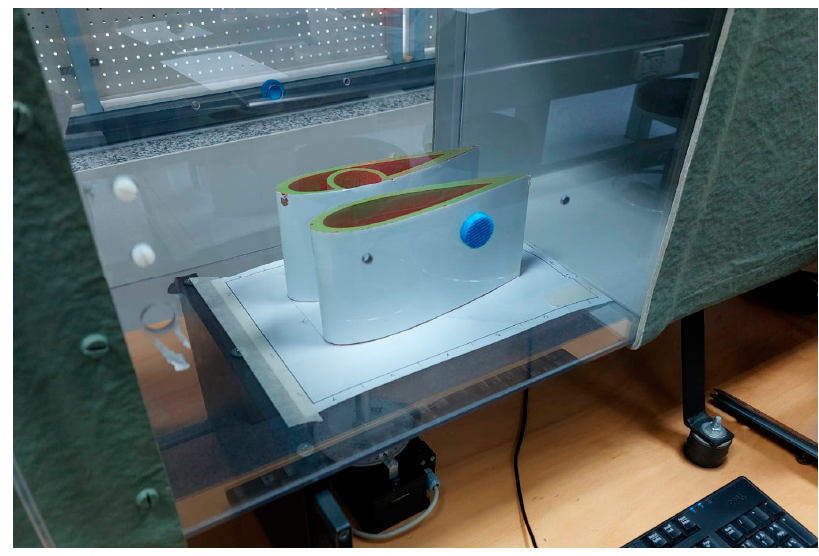
Figure 6. Three-dimensional printed augmentation system model inside a wind tunnel. Table 3. Experimental wind tunnel vs. CFD velocity data for the NACA 2424 augmentation system